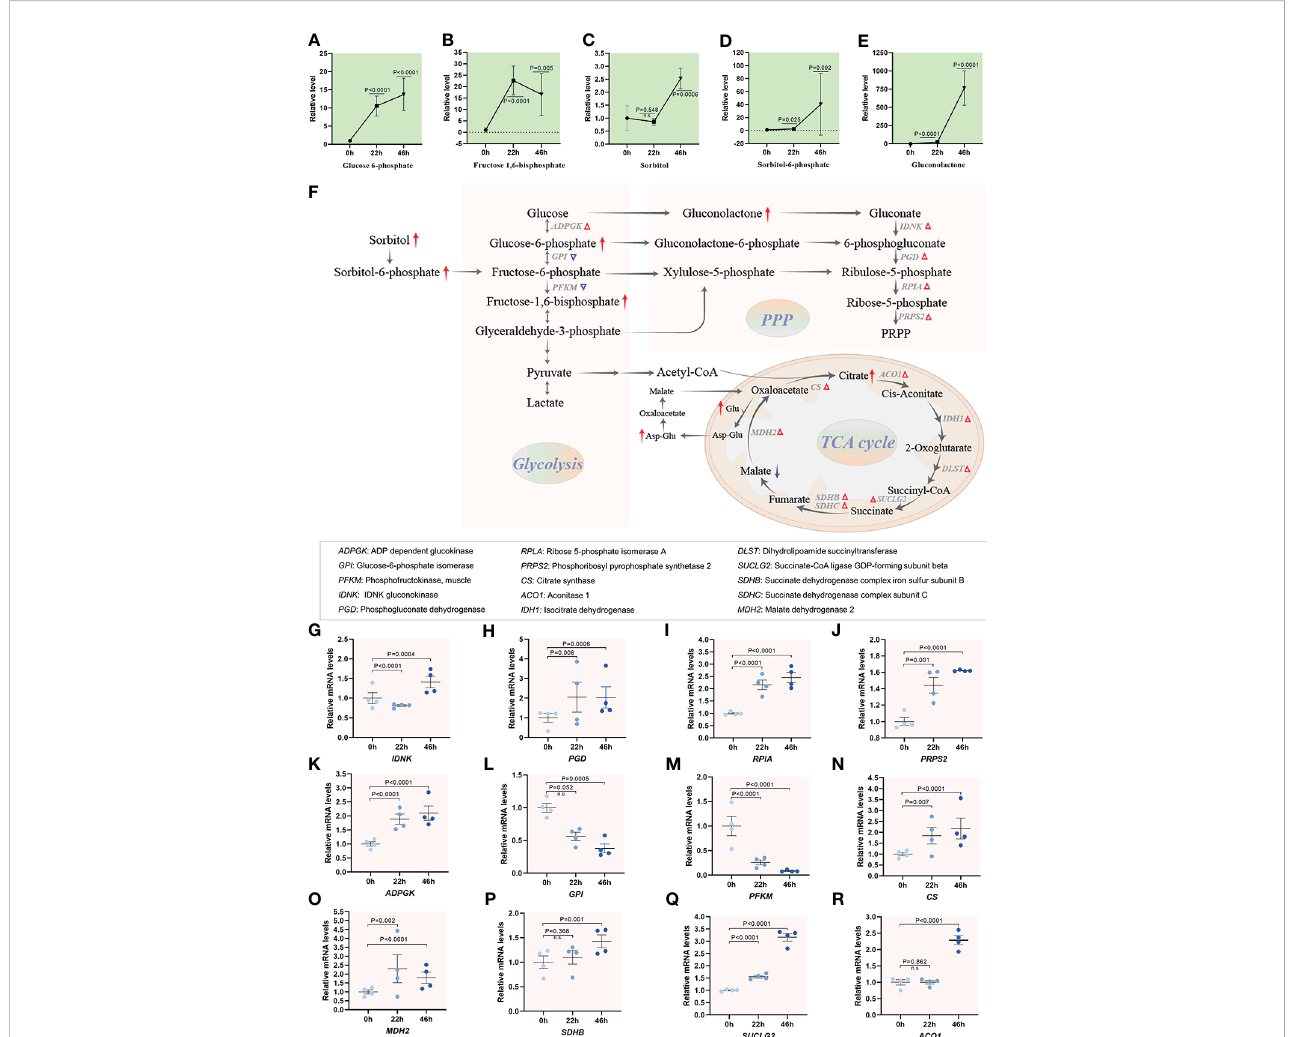
FIGURE 7 Carbohydrate metabolism activity during oocyte maturation. (A-E) Relative levels of metabolites related to carbohydrate metabolism in oocytes at three time points. (F) Schematic diagram of carbohydrate metabolism during meiotic maturation, derived from metabolomics and transcriptomics. The red and blue arrows denote the metabolites that are upregulated and downregulated, respectively. Differential expression genes increased and decreased are indicated by red and blue triangles. (G – R) Relative levels of differential expression genes involved in carbohydrate metabolism during oocyte maturation. Error bars, SD. Student ’ s t test was used for statistical analysis in all panels, comparing to GV. n.s., not signi fi